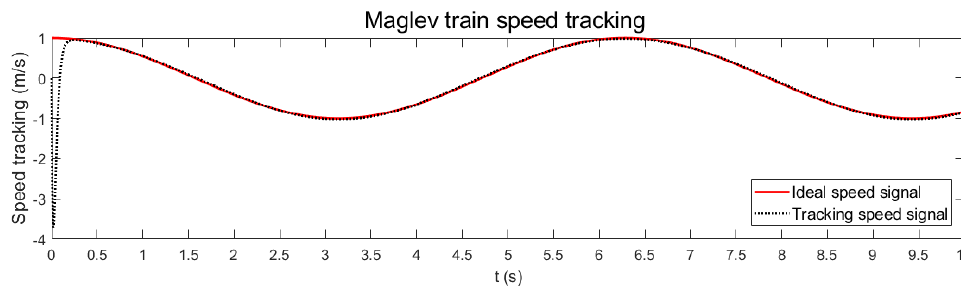
Figure 7. Speed tracking curve of a maglev train.